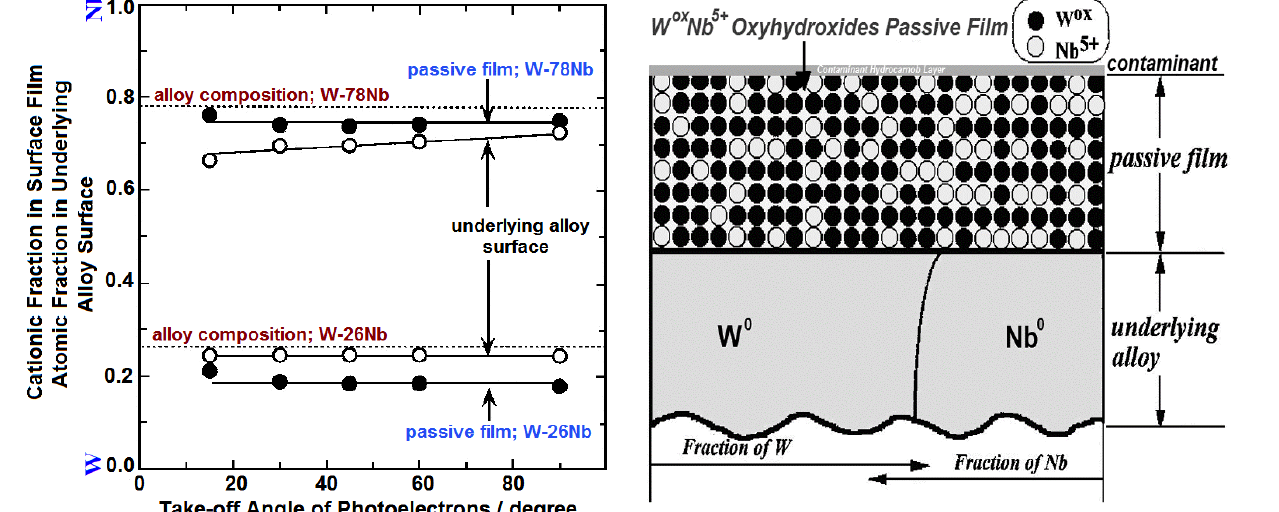
Figure 3: Changes of the apparent cationic and atomic fractions in surfaces formed on the W-26Nb and W-78Nb alloys, as a function of TOA.